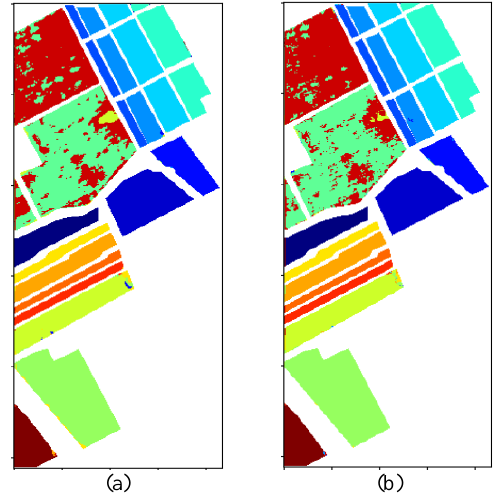
Figure 3. Classification results of the Salinas with simple MLP containing (a) one hidden layer (b) two hidden layers Various combinations of the convolutional and fully-connected layers with different input patch sizes were tested in order to find the optimal classifier network architecture. Three input patch sizes with dimensions of 3×3, 5×5, 7×7 were tested. Also, number of the tested convolutional and fully-connected layers vary between 1-2 and 0-2, respectively.